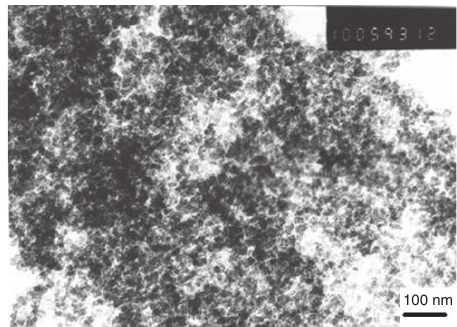
Figure 1 SEM image of silica nanoparticles.